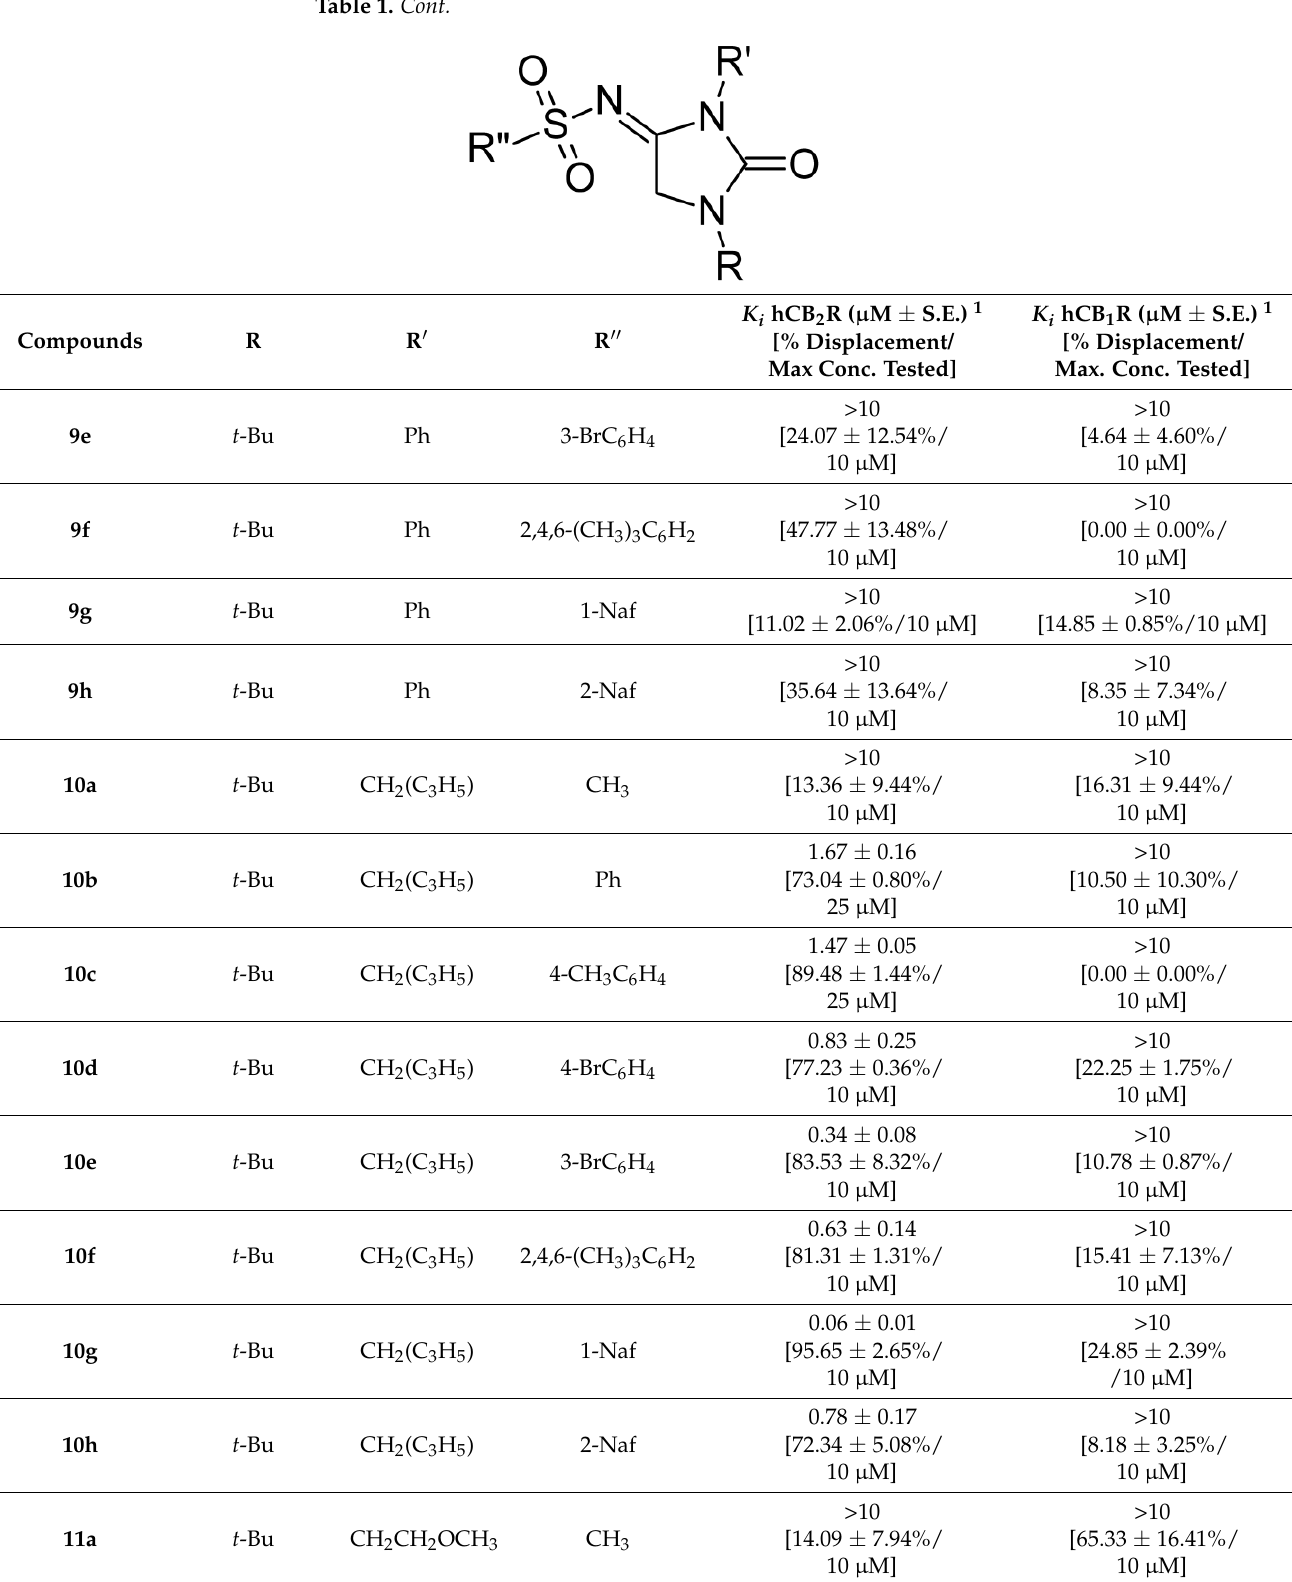
Table 1. Cont. Table 1. Affinity values for hCB1R and hCB2R of compounds of general